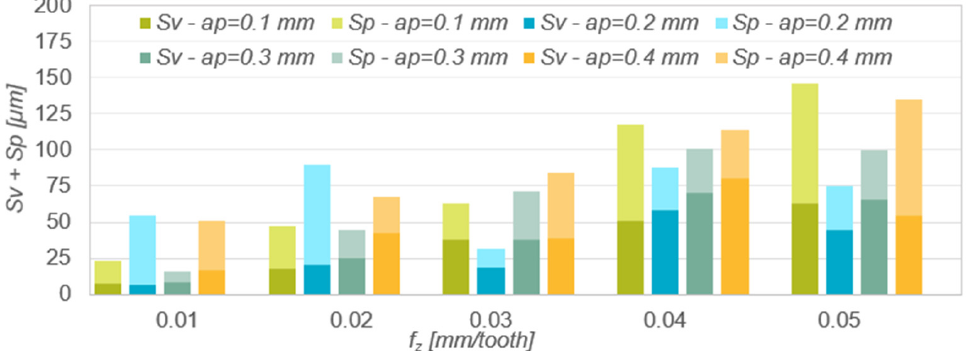
Figure 5. Results of measurements of roughness parameters Sv and Sp as a function of feed per tooth f z and depth of cut a p .